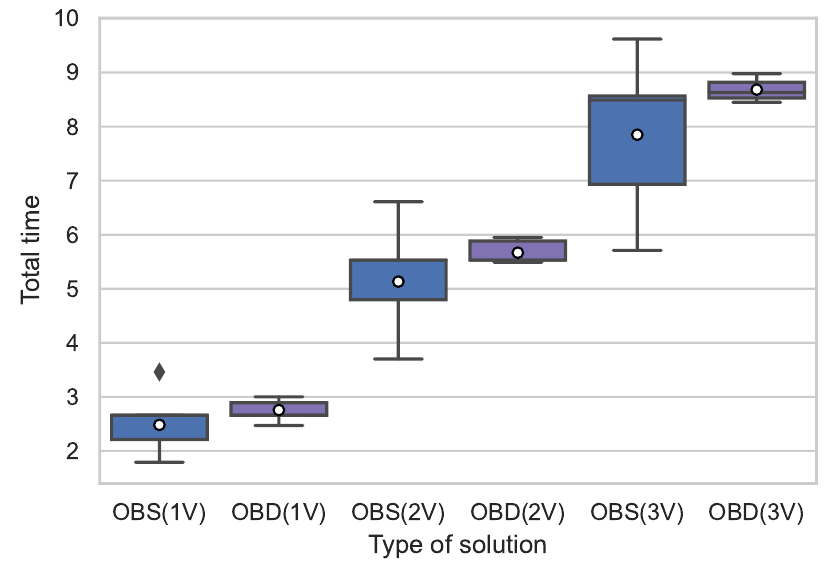
Figure 5. Costs obtained by each type of solution for different fleet